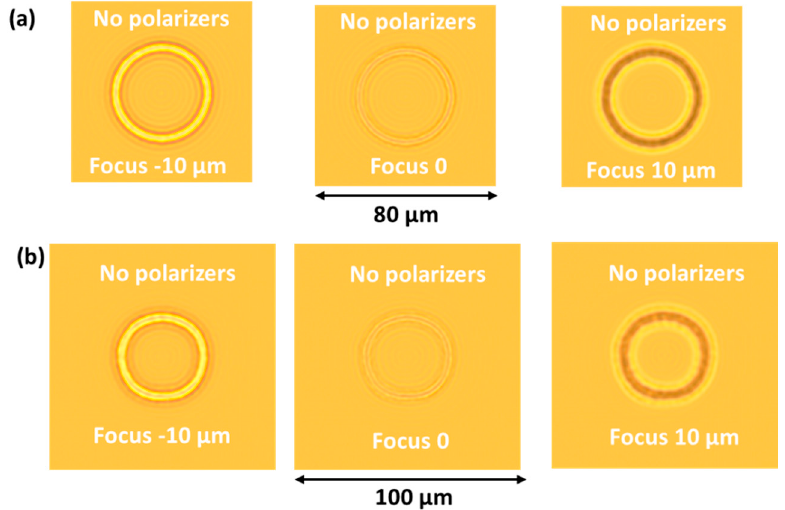
Figure 11. Simulated microscopy images for configuration 1 (80 µm × 80 µm × 5.5 µm unit cell, perfect overlap between the patterned rings) ( a ) and configuration 2 (100 µm × 100 µm × 5.5 µm unit, shift of 20 µm between the patterned rings at the top and bottom substrate) ( b ). Dimensions of the patterned rings at the top and bottom substrate r out = 30 µm (r in = 0.4 * r out ). The results are shown without polarizers, for 3 different focus distances (10 µm out-of-focus and in-focus).